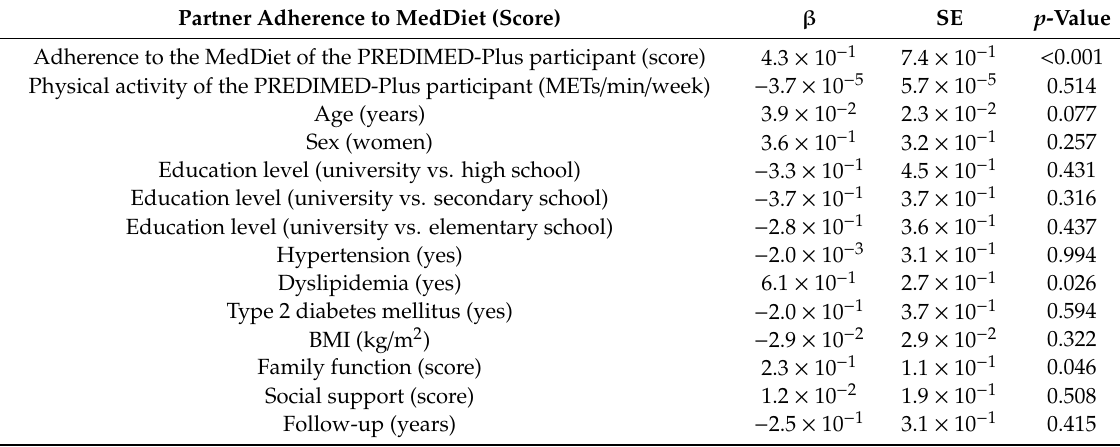
Table 4. Associations between adherence to the Mediterranean diet of PREDIMED-PLUS participants and adherence to the Mediterranean diet of their household